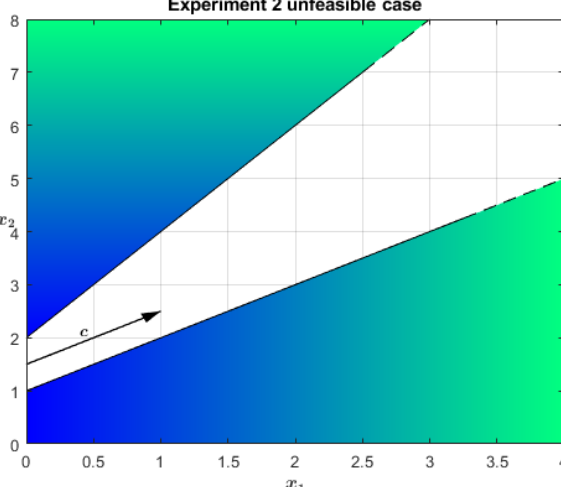
Figure 4. Example of an empty primal